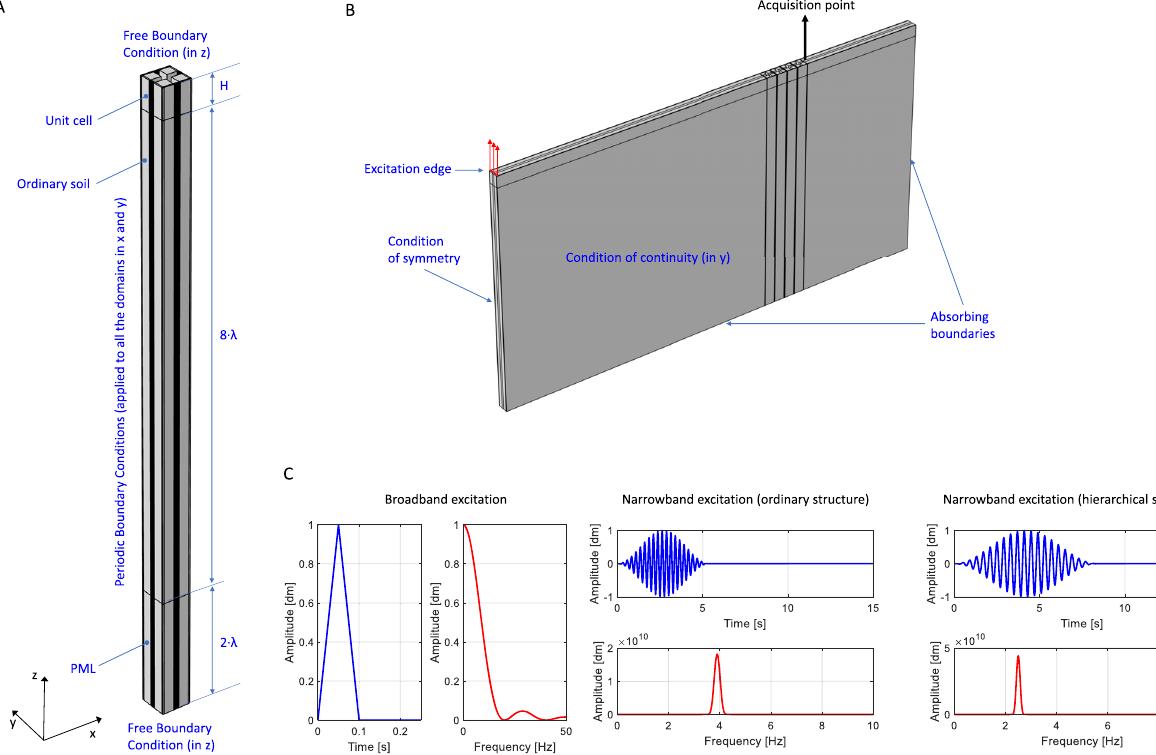
Fig. 2. Numerical models. (A) Schematic representation of the FE models used for the calculation of the dispersion curves localized at the surface. Free boundary conditions are applied to the top surface of the unit cell and a semi-in fi nite half-space is modeled through 8 l -long soil-like domain +a 2 l -long PML region. For the sake of synthesis, only the hierarchical unit cell is reported. (B) Schematic representation of the FE models used for the transient calculations. In this case, only the non hierarchical model is reported. (C) Time evolution and frequency content of the input signals used in simulations: (left panel) a triangular-like excitation and 21-cycle Hanning window modulated sinusoidal tone bursts centered at (central panel) 3.8 Hz and (right panel) 2.4Hz, respectively. The frequency spectrum clearly shows a rather broad-band and narrow-band frequency content, respectively. Displacement units are in decimeters